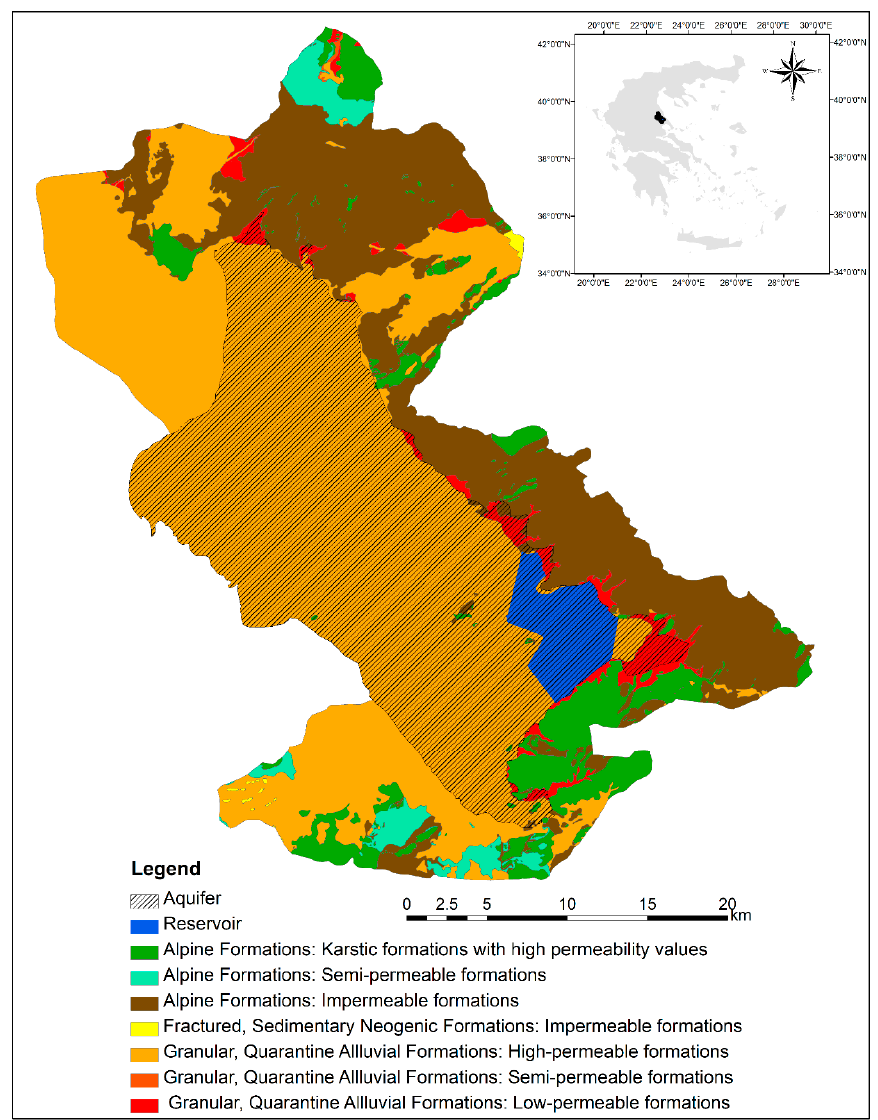
Figure 1. The study idea and its hydrogeological formations .